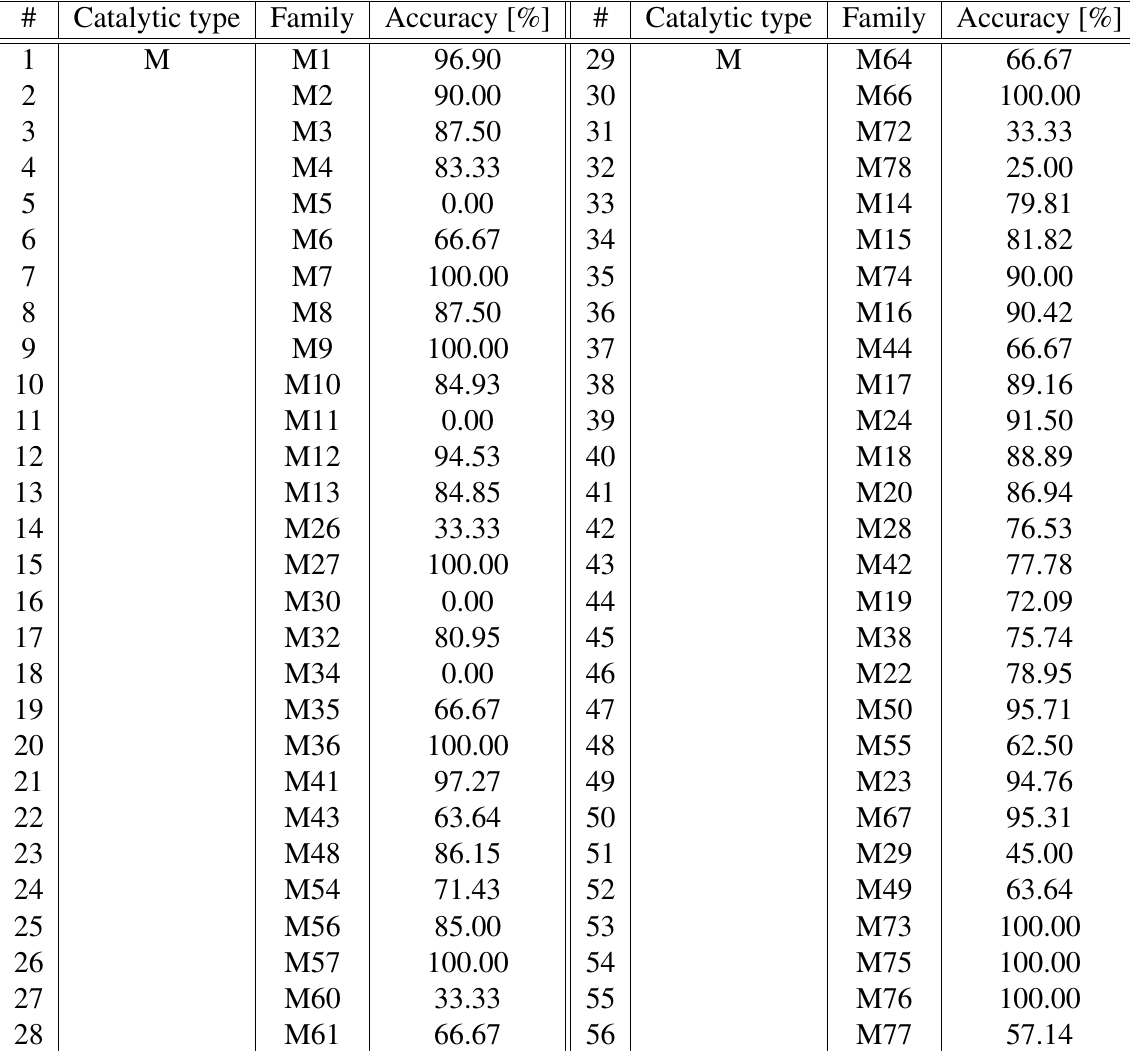
Table 10: Accuracy values for the SVM system for families from catalytic type